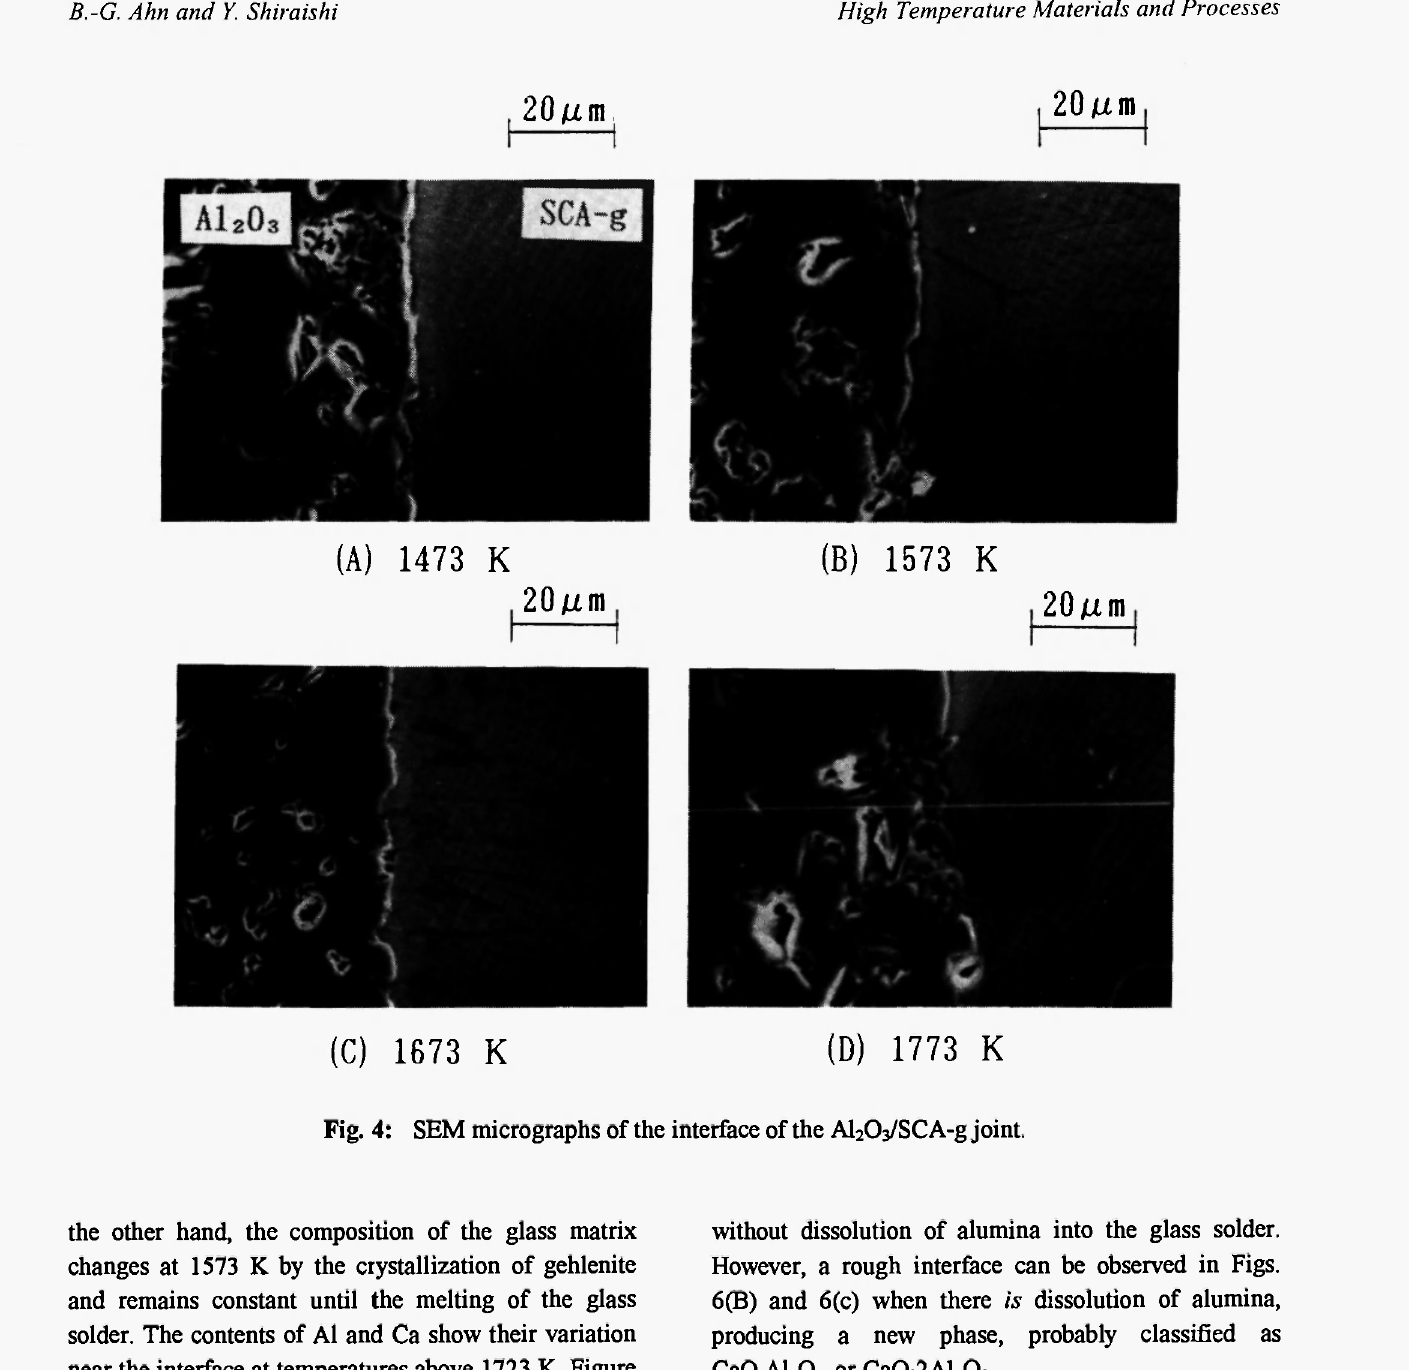
Fig. 4: SEM micrographs of the interface of the A^CVSCA-g